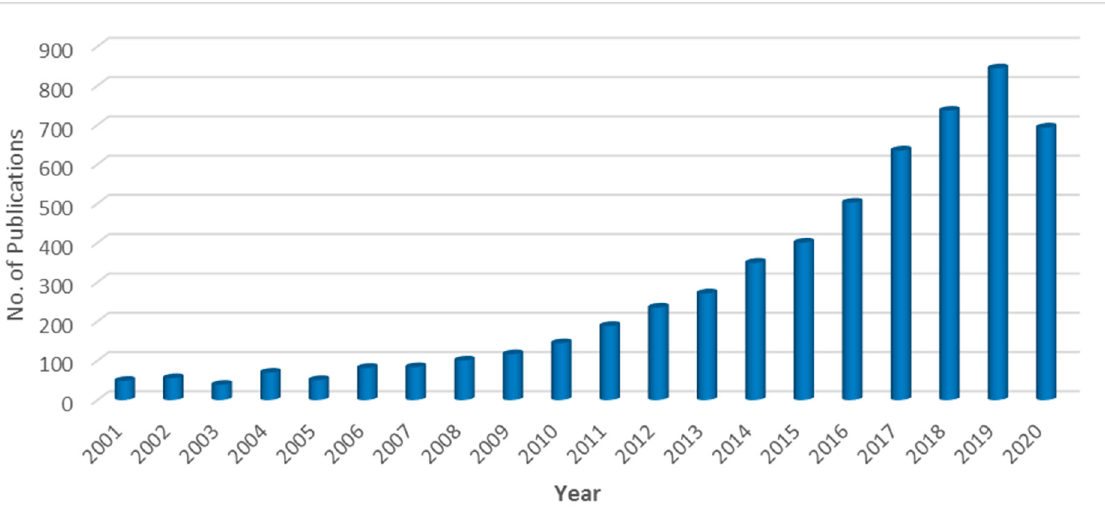
Figure 1. The number of publications each year since 2001 based on the keyword “Mixed matrix membrane” in the Web of Science database (data collected on 7 October 2020).